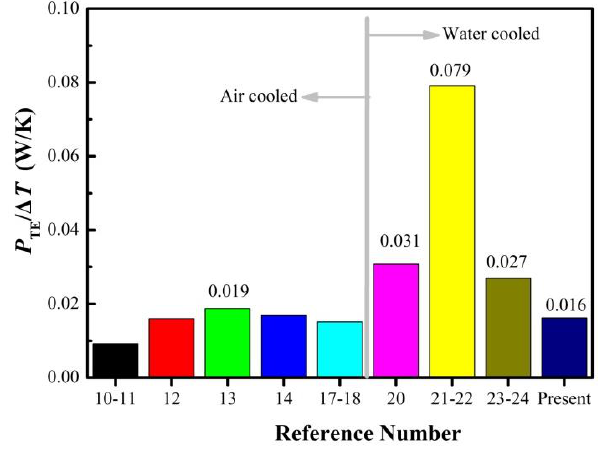
Figure 4. Comparisons of the electric power by each thermoelectric (TE) module per unit temperature difference.